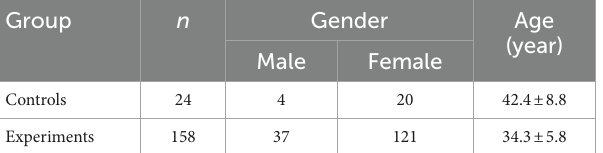
TABLE 1 Characteristics of